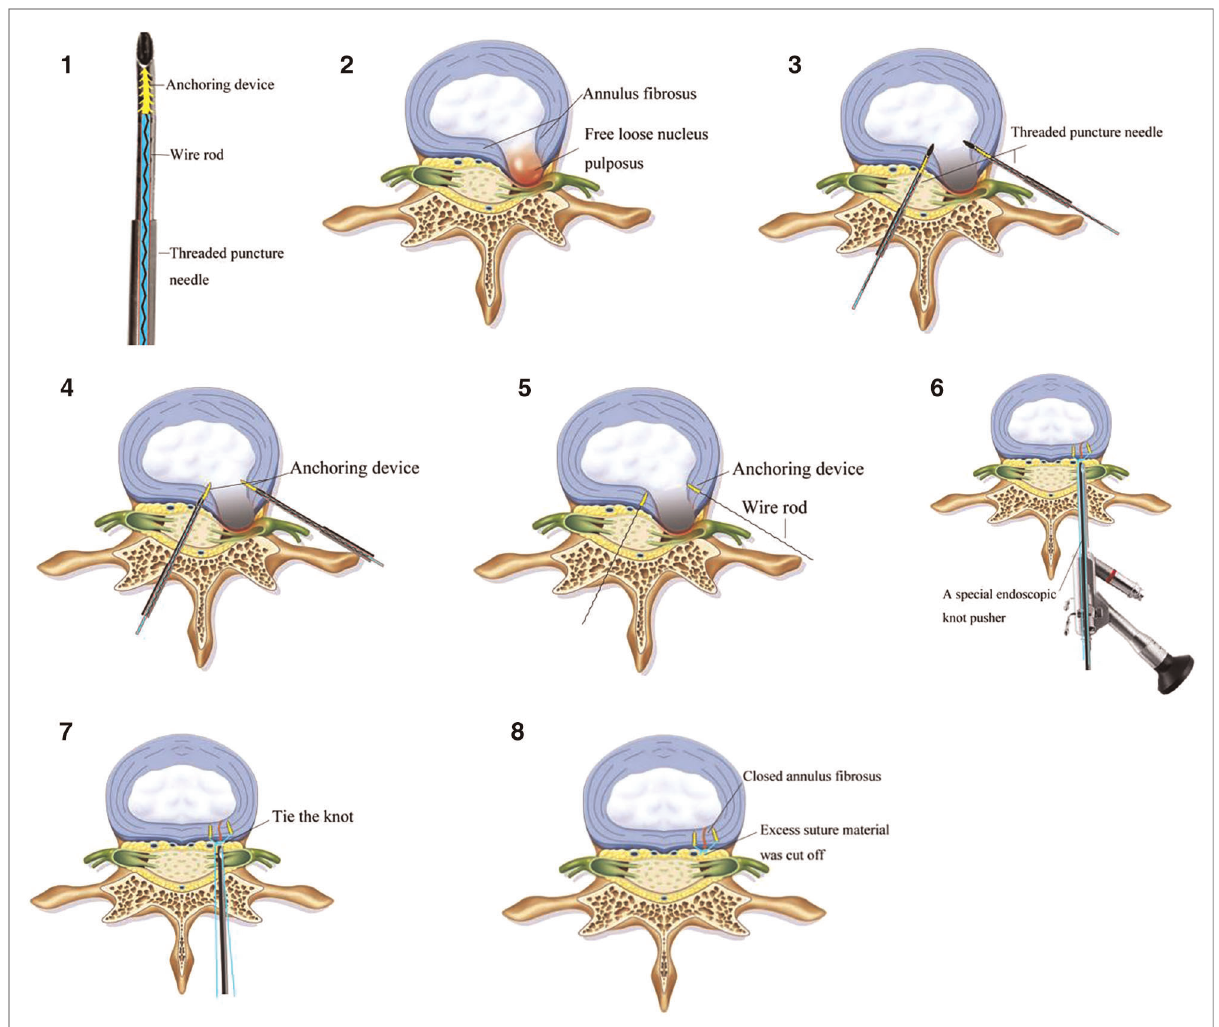
FIGURE 2 The diagrammatic drawing of the annulus fi brosus suture process. 1. The threaded puncture needle of the annulus fi brosus suture device. 2. The free loose nucleus pulposus. 3. The threaded puncture needle of the annulus fi brosus suture device was pierced into the annulus fi brosus at the bilateral breach. 4. The guidewire pushed the built-in wire rod with anchoring device into the annulus fi brosus. 5. The guidewire pushed the built-in wire rod with anchoring device into the annulus fi brosus, and the needle and guidewire were withdrawn to complete the implantation of the suture. 6 – 7. A special endoscopic knot pusher was used to tie the knot to repair the annulus fi brosus defect. 8. Excess suture material was cut